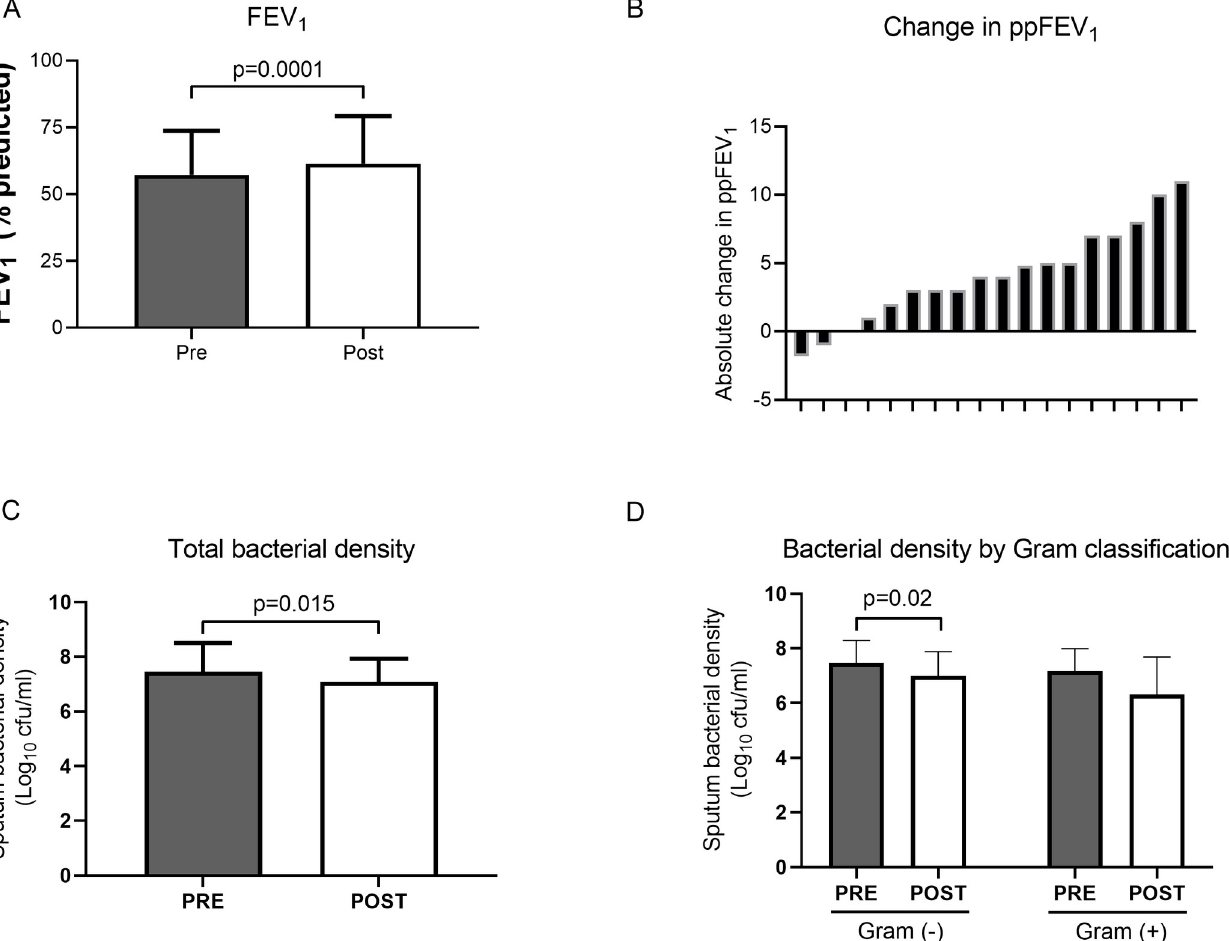
Fig 2. Effect of inhaled AZLI on standard variables pre and post treatment. (A) percent predicted Forced Expiratory Volume in the first second (ppFEV 1 ), (p = 0.0001, paired t-test); (B) Waterfall plot demonstrating ppFEV 1 change per patient, each subject represented by tick marks on x-axis; (C) Total bacterial density based on quantitative sputum cultures (p = 0.015, paired t-test following log transformation); and (D) bacterial density by gram staining classification. Gram negative organisms showed a significant decrease post treatment (p = 0.02, paired t-test following log transformation). Solid columns represent pre-treatment; open columns represent post-treatment. Bars represent mean values and error bars represent SDs on the same scale as means.